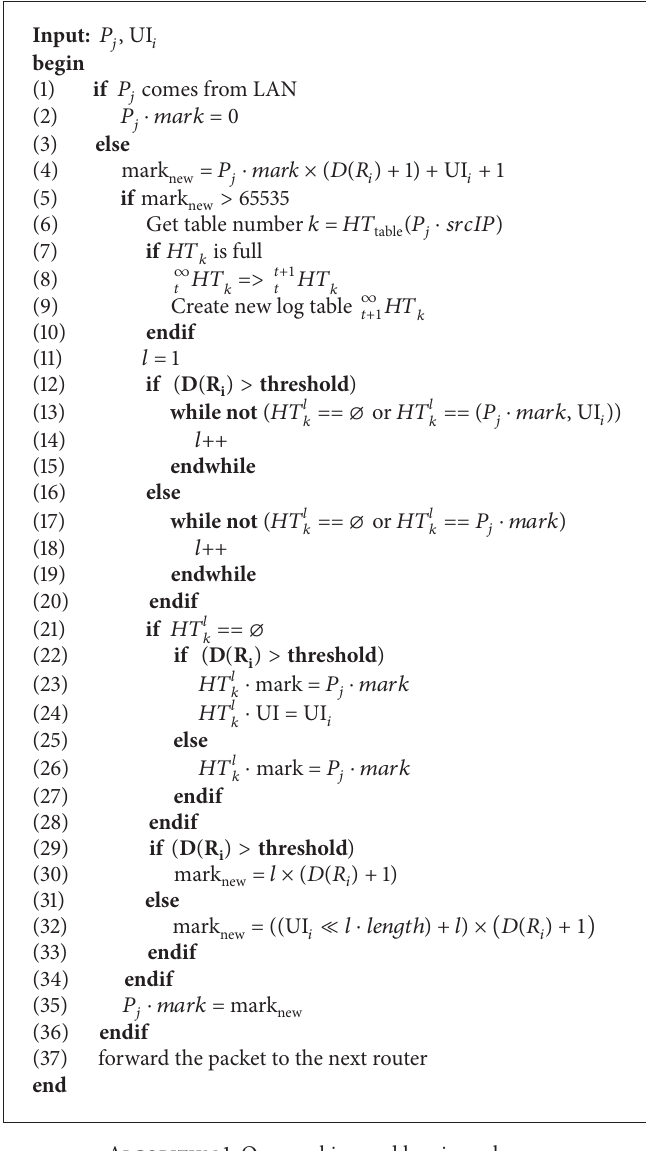
Algorithm 1: Our marking and logging